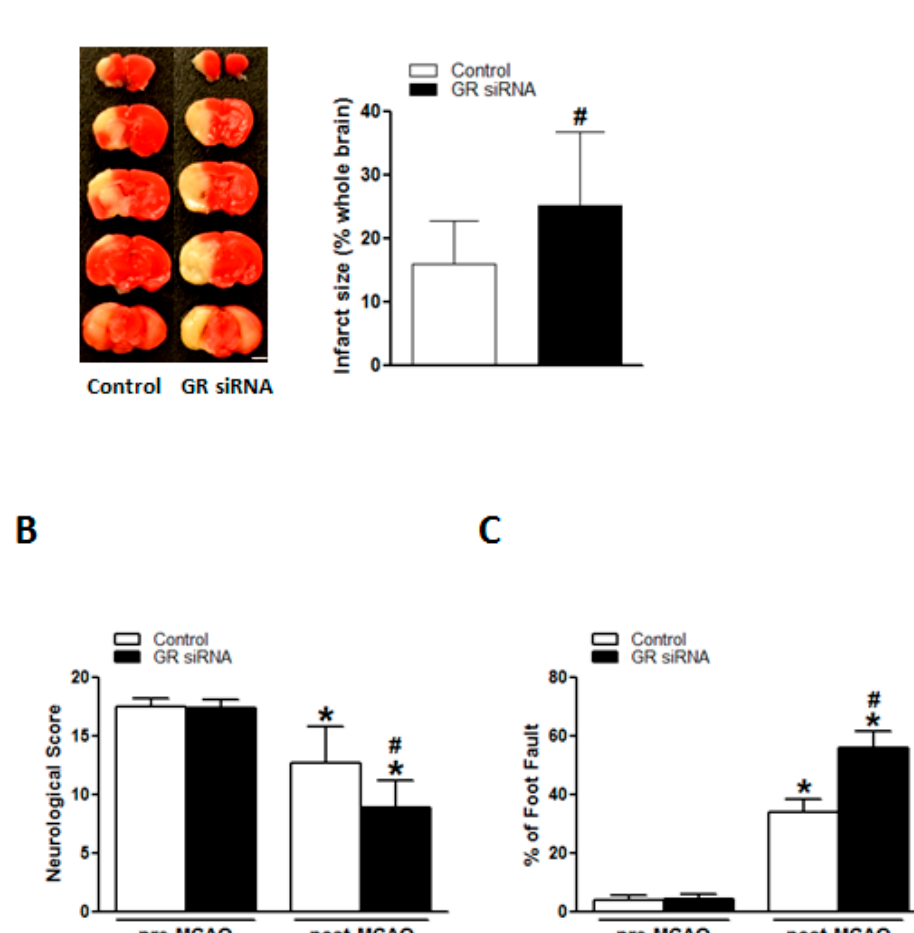
Figure 5. The GR repression increased the infarction size and worsened neurobehavioral deficits in mice with MCAO. The mice received either GR siRNA (100 pmol) or its negative control (Neg. Control; 100 pmol) via intracerebroventricular (i.c.v.) injection. A middle cerebral artery occlusion (MCAO) was performed 48 h after i.c.v. injection. The brain infarction size was assessed 48 h after MCAO conduction ( A ). Neurobehavioral tests including Neurological Score ( B ) and Foot Fault ( C ) were evaluated before MCAO conduction and 48 h after MCAO conduction, respectively. n = 10–12. * p < 0.05, pre-MCAO vs. post-MCAO; # p < 0.05, GR siRNA vs. Control. Scale bar, 2 mm.